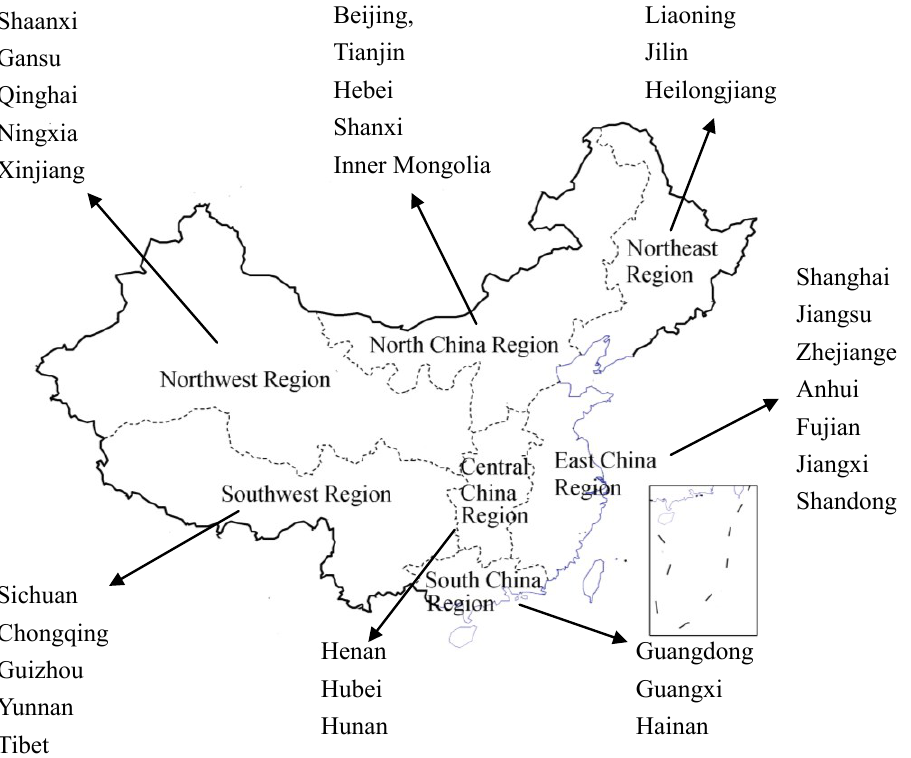
Figure 1. Division of different regions in China. The provinces that are included in each region are also